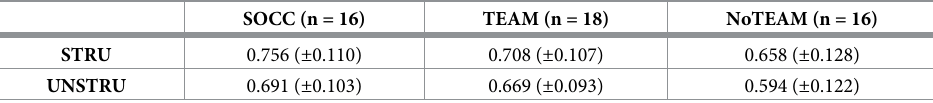
Table 2. Description of the mean (standard deviation) tracking performance by group and